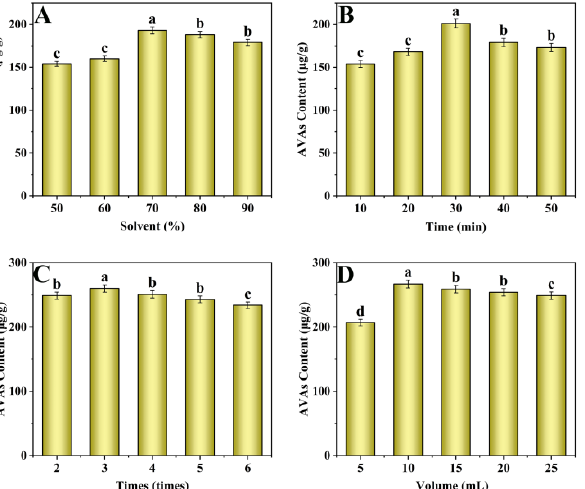
Figure 1. Optimization of the extraction conditions for AVAs: ( A ) solvents, ( B ) time, ( C ) number of extractions, and ( D ) volume of extraction solution. Letters above the columns represent significant difference at p < 0.05.